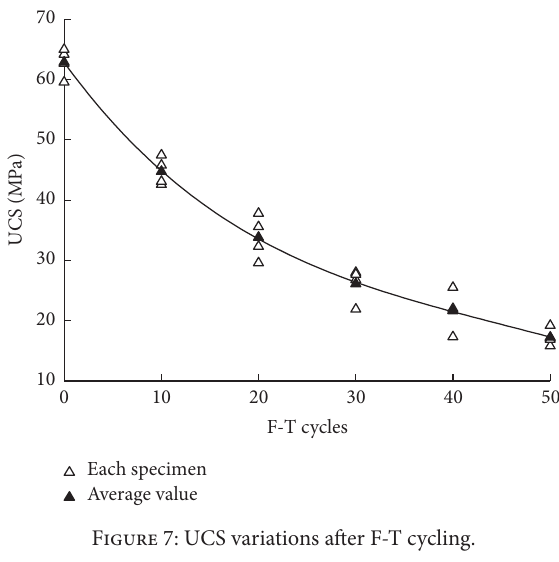
Figure 5: Relationship between the P-wave velocity and Young’s modulus.